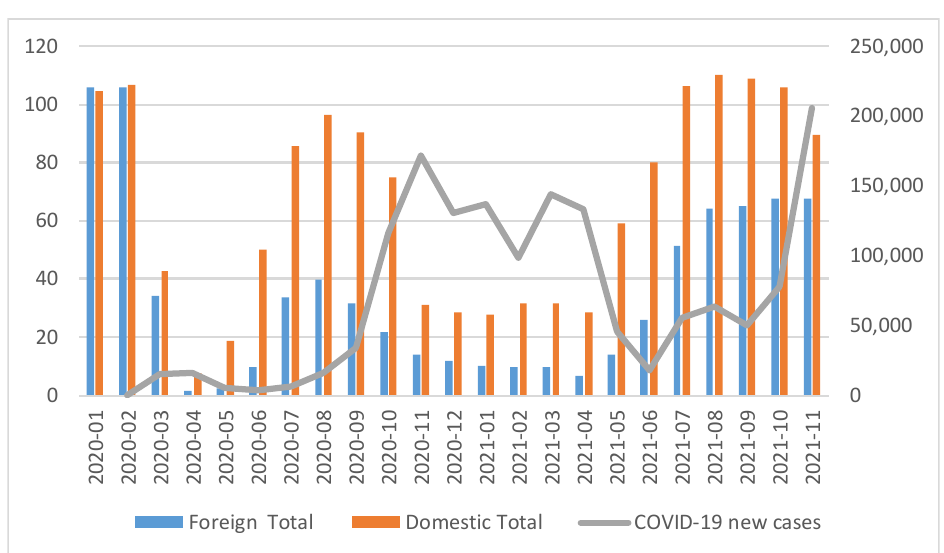
Figure A1. Overnight stays at tourist accommodation establishments—European Union 27 countries (EU27) (2019 = 100) and monthly average of new reported COVID-19 cases in EU27 and EFTA countries. Source: Eurostat monthly data [TOUR_OCC_NIM__custom_2135440] extracted on 21 February